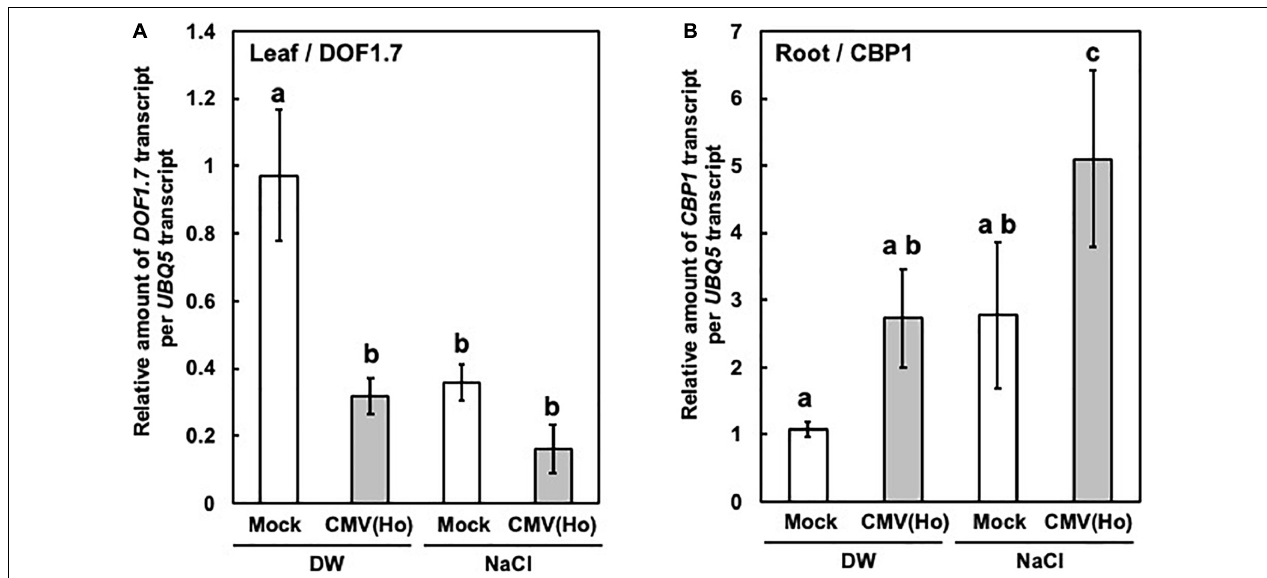
FIGURE 13 | DOF1.7 and CBP1 expression in CMV(Ho)tr-infected and mock-infected A. thaliana ecotype Col-0. Relative levels of DOF1.7 transcripts in CMV(Ho)tr-inoculated and mock-inoculated Col-0 leaves (leaf/DOF1.7) (A) and CBP1 transcripts in CMV(Ho)tr-inoculated and mock-inoculated Col-0 main roots (root/CBP1) (B) were measured by qPCR. The plants were treated with distilled water (DW) or NaCl (NaCl). The average relative amounts of DOF1.7 or CBP1 transcripts in CMV(Ho)tr-inoculated samples from three independent samples are shown by a gray bar chart with error bars ( n = 3, SD), and their levels in mock-inoculated samples from three independent samples are indicated by a white bar chart with error bars ( n = 3, SD). The different letters indicate a statistically significant difference in the average of relative amounts of DOF1.7 or CBP1 transcript (Turkey’s test, p <